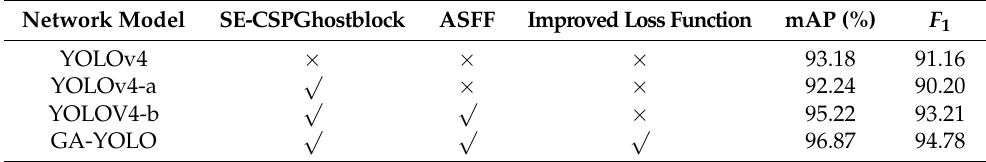
Table 8. The grape detection results of the four network models.